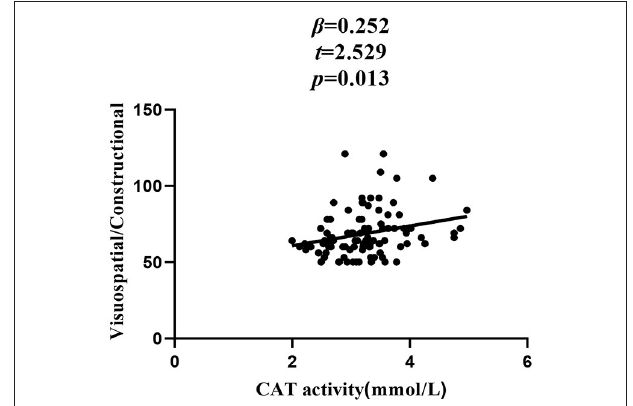
FIGURE 3 | Correlation between plasma CAT activity and Visuospatial/Constructional score in chronic schizophrenia patients.